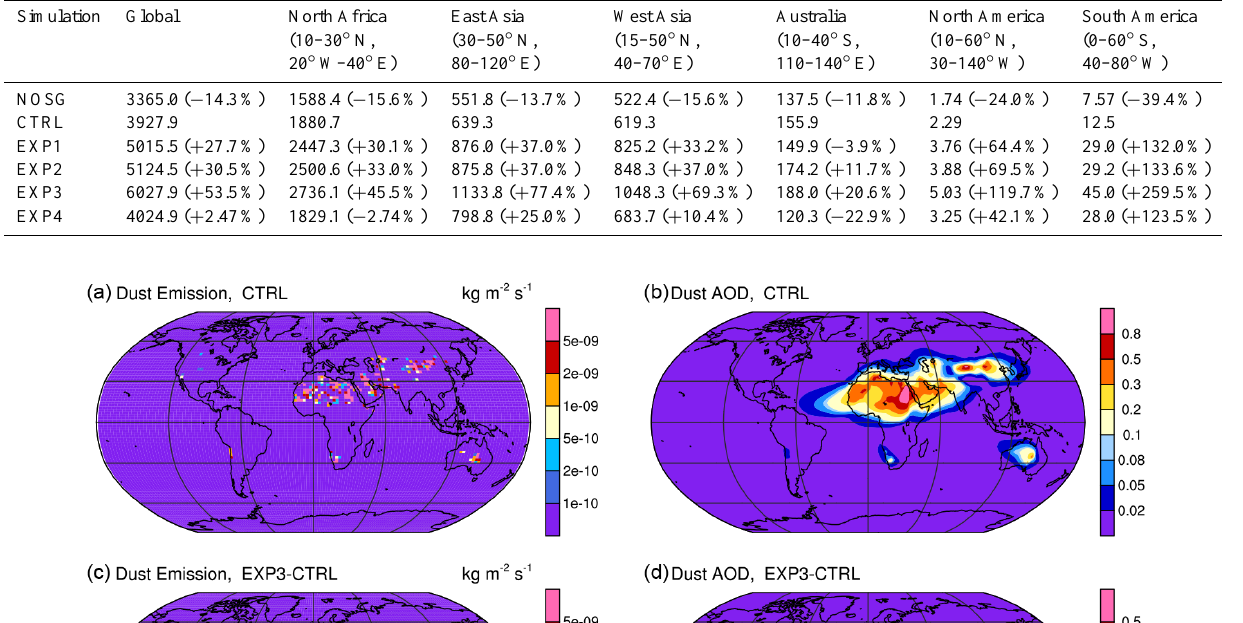
Table 3. Simulated annual mean global and regional dust emission (Tgyr − 1 ) for the year 2006. Numbers in parenthesis are the relative differences with respect to the default model (CTRL). The experiment configurations are explained in Table 1.